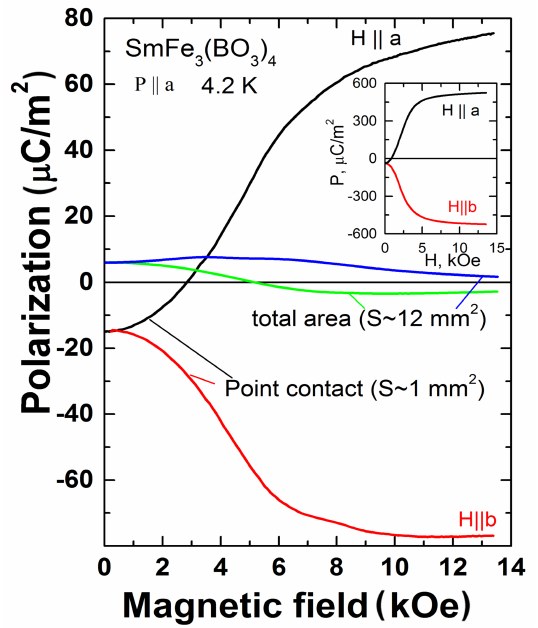
Figure 3. Behavior of the a -component of the electric polarization on the magnetic field applied along the a - and b ∗ -axes in SmFe 3 (BO 3 ) 4 a-cut plate measured for the total area of the plate ( ∼ 12 mm 2 ) and small point contact ( ∼ 1 mm 2 ), which illustrates the role of twins on magnetoelectric properties. The inset shows the polarization behavior for the practically twin-free sample studied in